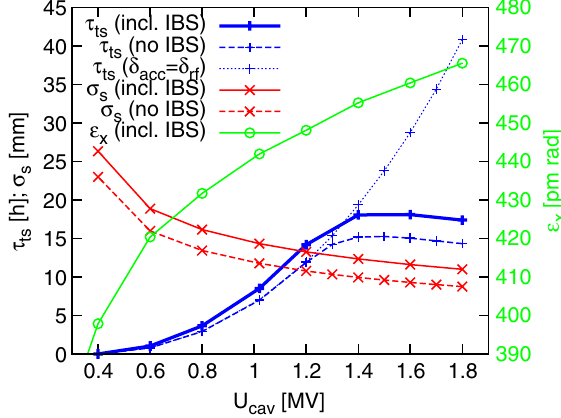
FIG. 5. Touschek lifetime, bunch length, and horizontal emit- tance in the MAX IV 3 GeV storage ring bare lattice as functions of the rf cavity voltage. The stored current was assumed to be 500 mA with the vertical emittance always adjusted to 8 pm rad. Bunch lengthening from LCs has not been included.